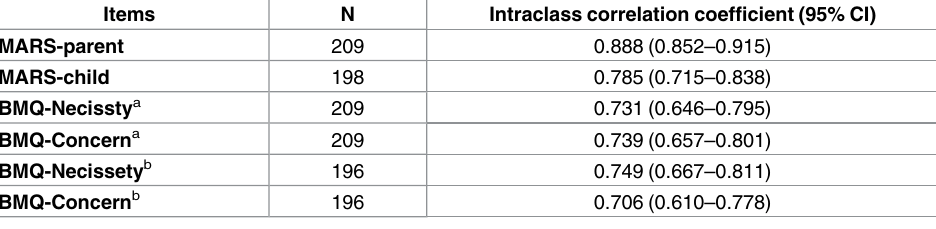
Table 4. Test–retest reliability as assessedby ICC for MARS, BMQ-specific Items for parents and children. Items